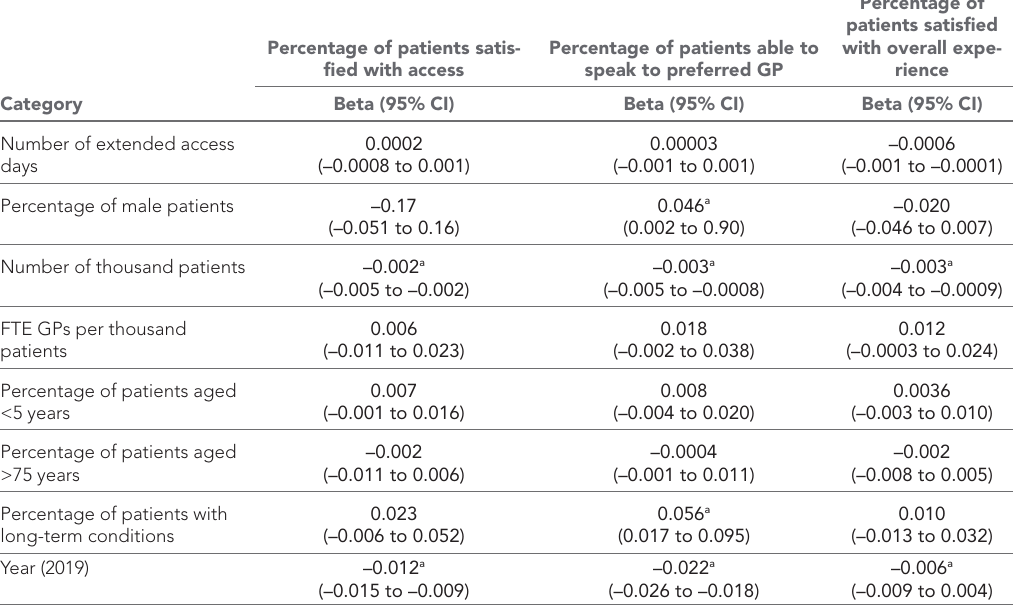
Table 4 Regression outputs. N = 5829 practices. Estimates are from linear regression models and include practice fixed effects (not reported), standard errors are robust to